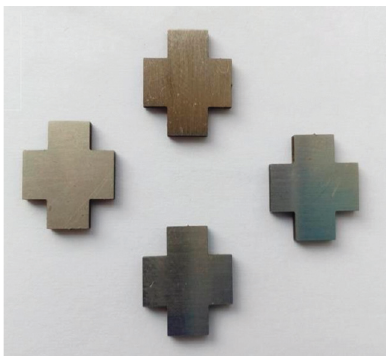
Figure 6: Wire EDM component profile.